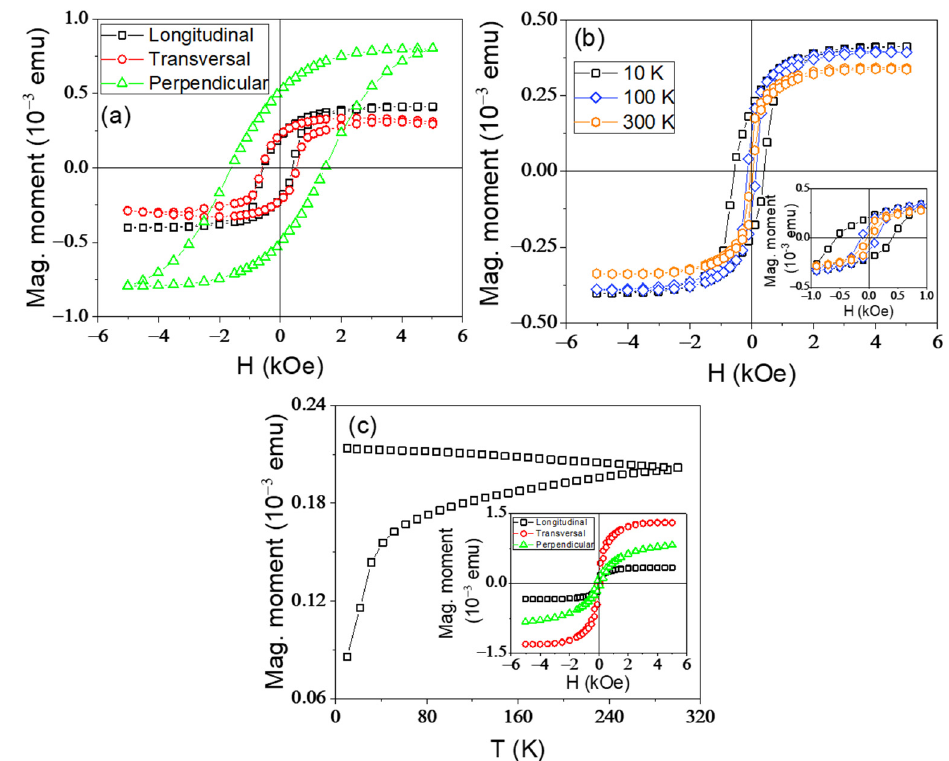
Figure 6. Hysteresis loops of 15 nm FeCo film grown on more distanced trenches, collected at 10 K in longitudinal, transversal, and perpendicular geometry ( a ); hysteresis loops as a function of temperature in longitudinal geometry ( b ). Insets present an enlarged image of the hysteresis loops around the origin. ZFC-FC curve in longitudinal geometry. Inset shows the hysteresis loops collected at 300 K in different geometries ( c ).